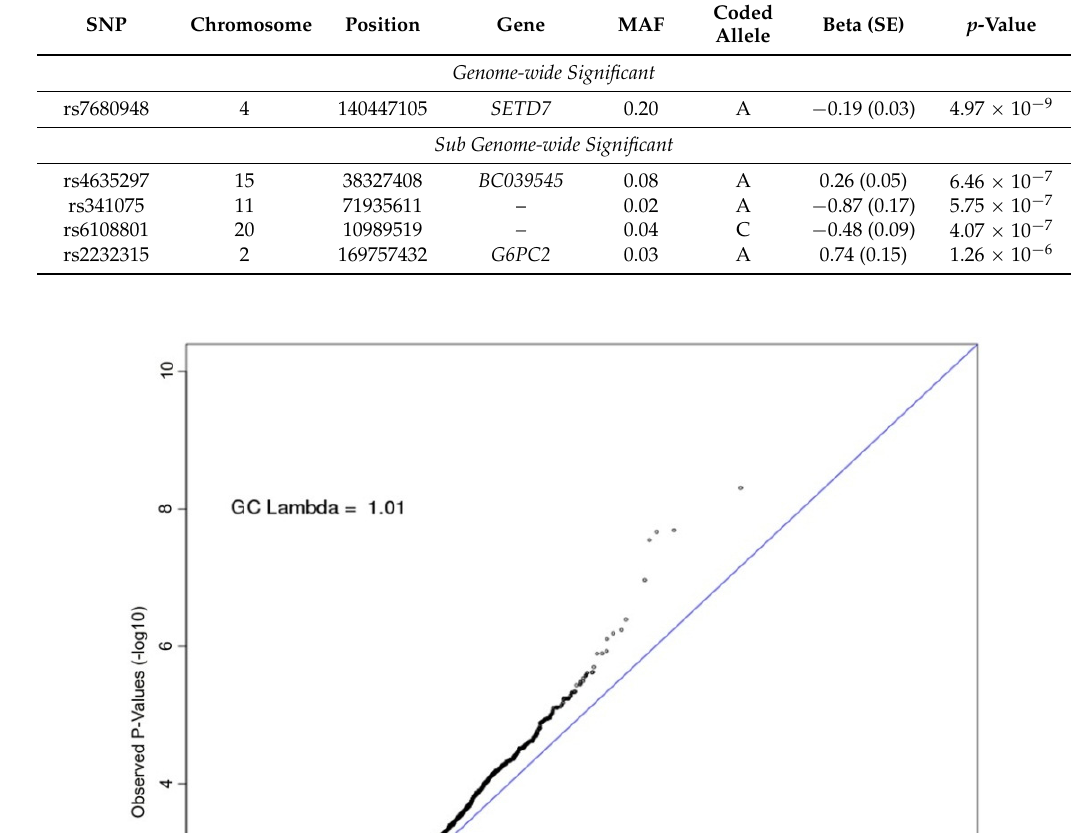
Table 2. Genome-wide ( p < 5 ˆ 10 ´ 8 ) and sub genome-wide (5 ˆ 10 ´ 8 ď p < 1 ˆ 10 ´ 6 ) associations with serum lycopene concentrations.